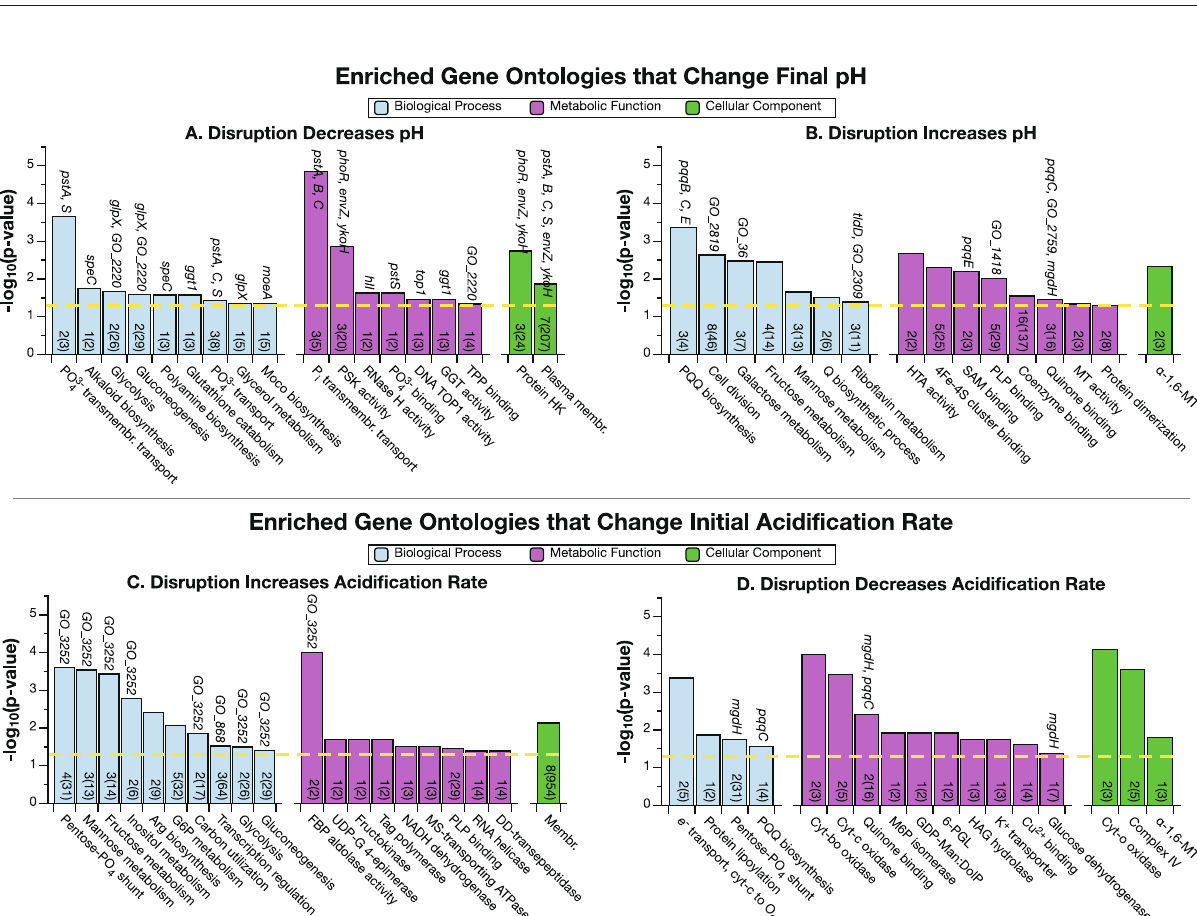
Fig. 2 High-throughput pH screens of the G. oxydans whole genome knockout collection were used to identify genes that control REE bioleaching. A Thymol blue (TB) was used to measure the endpoint acidity of biolixiviant produced by each well of the condensed collection. The ratio of TB absorbance (A) at 435 and 545 nm is linearly related to pH between 2 and 3.4 (Supplementary Fig. 1). CC plate 65 contains biolixiviant produced by δ pstB strain in wells F7 and G7 (arrowhead), whose absorbance at 435 and 545 nm are shown (middle panel, red dots), along with the average absorbance of all occupied wells on the plate ( n = 94) (white dot; error bars are SEM). The dashed line represents a typical absorbance spectrum for WT-produced biolixiviant. The A435/A545 ratio for these two wells (right panel, red bars and dots) compared with the mean ratio of the plate (orange bar; orange dots show individual data points) is well below the lower bound (LB) for the plate, indicating that δ pstB produces a much more acidic biolixiviant than the average strain. B Bromophenol blue (BPB) was used to measure rate of change in pH at the onset of glucose conversion to organic acids. Rate was measured over a 6 min period within fi ve minutes of adding bacteria to a glucose and BPB solution. Condensed collection (CC) plate 162 contains the δ tldE strain in wells F11 – C12 (arrowheads), whose changes in absorbance over time are graphed along with the average for that plate (middle panel, n = 94). A comparison of the normalized rate over OD for each well (right panel, dark blue bars and dots) versus the plate mean (light blue bar; dots show individual data points) shows how V /OD for these wells was below the lower bound for CC plate 162. C All 185 plates of the CC were screened for acidi fi cation using TB and BPB assays. Hits from both screens were veri fi ed in comparison with proxy WT strains. In total, 176 disruption strains were shown to signi fi cantly contribute to acidi fi cation. D , E Comparisons with proxy WT strains were made by a two-tailed t -test with a Bonferroni-corrected alpha ( α = 0.05/ N where N is the number of comparisons). Bars represent mean values and dots represent individual data points. Error bars represent standard deviation. D The 25 largest signi fi cant reductions in biolixiviant pH and 50 largest signi fi cant increases in biolixiviant pH. N = 120 or N = 242 for comparisons with pWT set A or set B, respectively. (The full data set and number of biological replicates for each strain can be found in Supplementary Data 6E). E All signi fi cant changes in